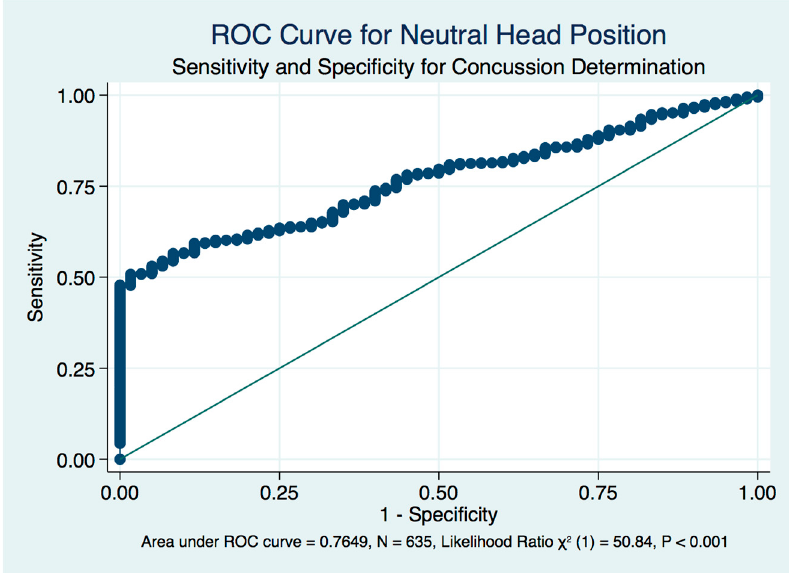
Figure 9. Receiver operating characteristic (ROC) curve for head neutral, eyes closed perturbed testing in concussion determination.